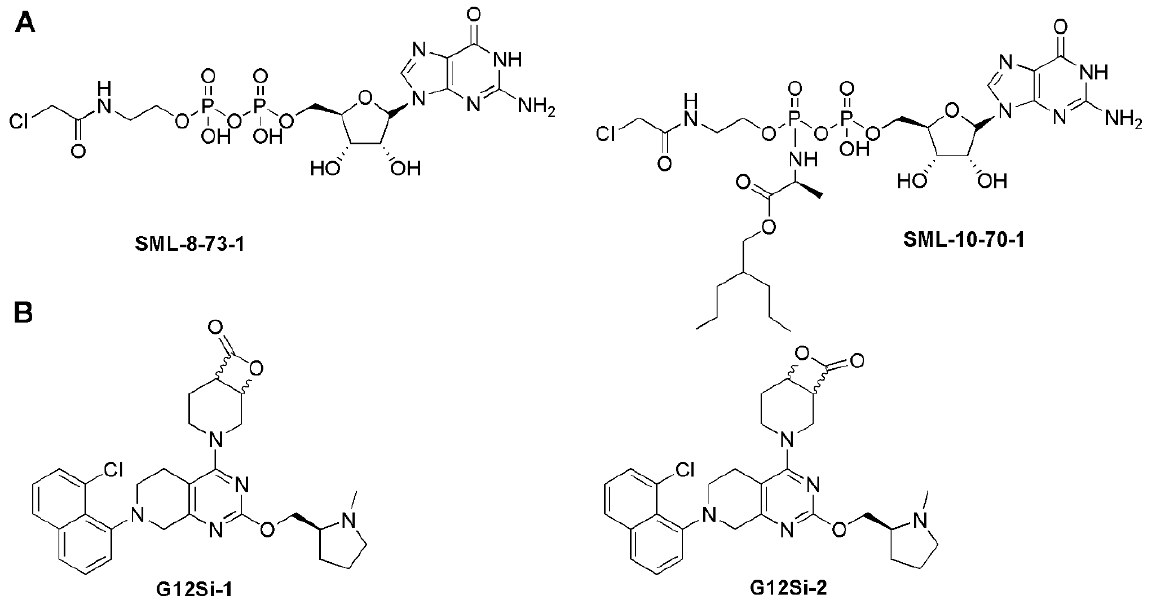
Figure 3. ( A ) Covalent substrate (GTP/GDP)-competitive inhibitors. ( B ) The KRAS-G12S-speci fi c in- hibitors.